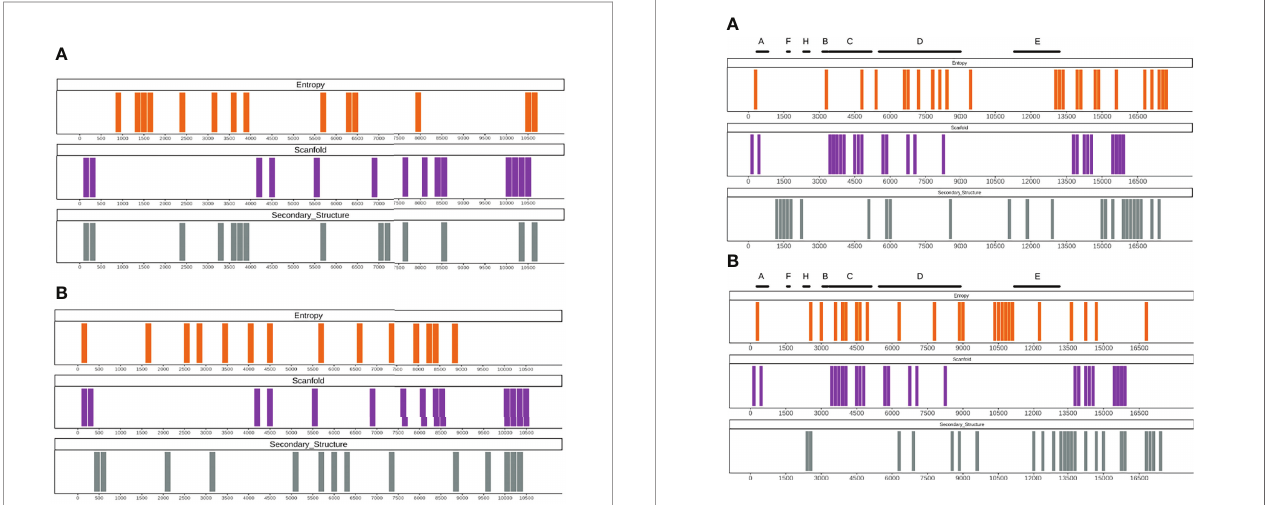
FIGURE 4 | (A) Outputexampleofthe RNAvigator pipelinefor thecomplete DENV-1genomeshowingthe bottom20%regionsforSHAPEreactivity (Secondary_Structure;gray), Scanfold z-score(Scanfold;purple),andtheentropy obtainedbyusingSHAPEdataasinputinside Superfold (Entropy; orange). (B) Outputexampleofthe RNAvigator pipelinefor thecompleteDENV-1genome showingthebottom 20% ofregionsfor CROSS predictions (Secondary_Structure; gray), Scanfold z-score(Scanfold; purple),andthe entropyobtainedbyusing CROSS SHAPE-likedataas input inside Superfold (Entropy;orange).